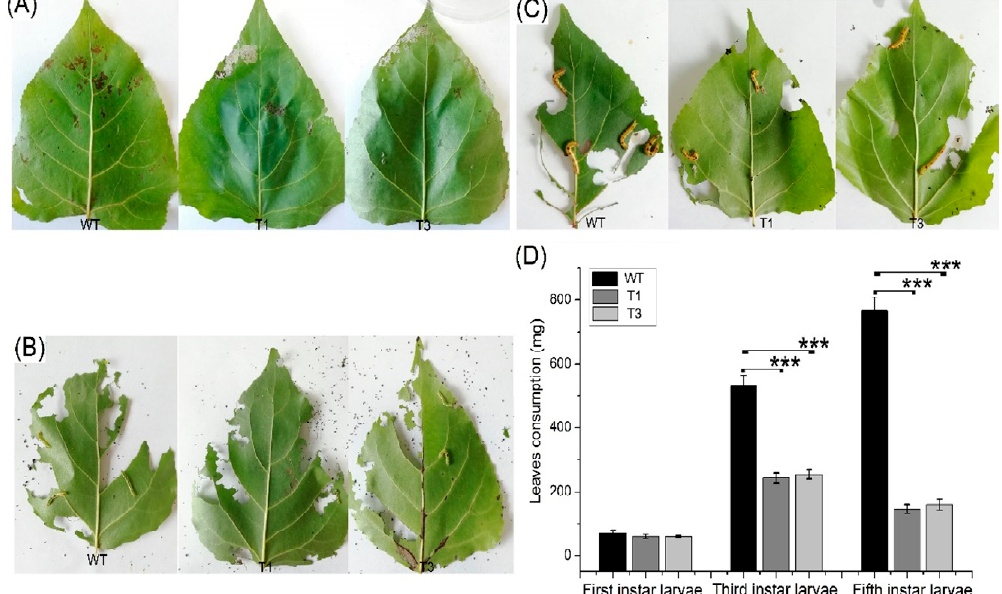
Figure 8. M . troglodyte feeding assay. ( A ) Leaves of WT and PtDXS -transgenic plants after initiating to be eaten by first instar larvae. ( B ) Leaves of WT and PtDXS -transgenic plants after after initiating to be eaten by third instar larvae. ( C ) Leaves of WT and PtDXS -transgenic plants after after initiating to be eaten by fifth instar larvae. ( D ) Quantitative data for leaves of WT and PtDXS -transgenic plants. Three independent experiments were performed; asterisks represent significant differences relative to WT plants (Student’s t -test; ***, and p < 0.001, respectively).